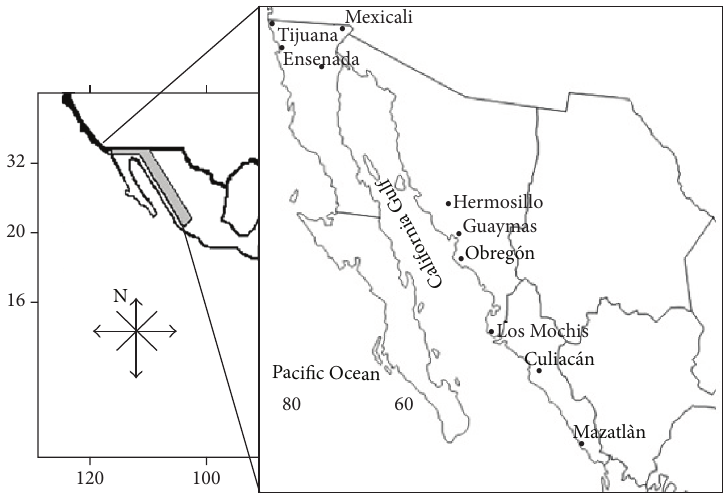
Figure 1: Location of the nine cities visited for